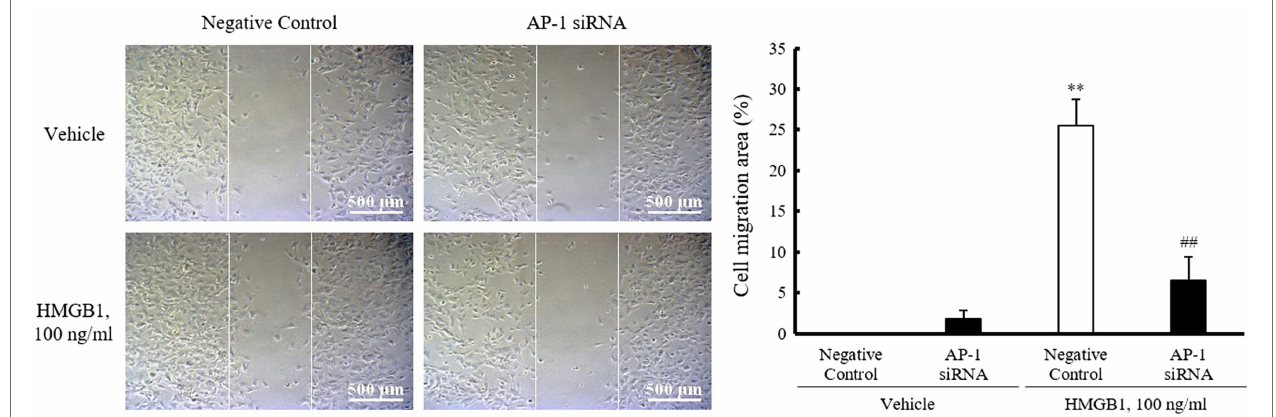
FIGURE 5 | Role of AP-1 in HMGB1-induced VSMC migration. VSMCs were transfected with AP-1 siRNA (200 nM) for 48 h and then stimulated with HMGB1 (100 ng/ml) 48 h. Cell migration was determined by wound-healing assay. Representative photomicrographs of cell monolayers at 48 h post-wounding. Cell migration area (%) was calculated from the ratio of changes in wound area. Scale bar: 500 μ m. Data were quantified, expressed as the mean ± SEM of five independent experiments. ** p < 0.01 vs. value in negative control in vehicle and ## p < 0.01 vs. corresponding value in negative control in